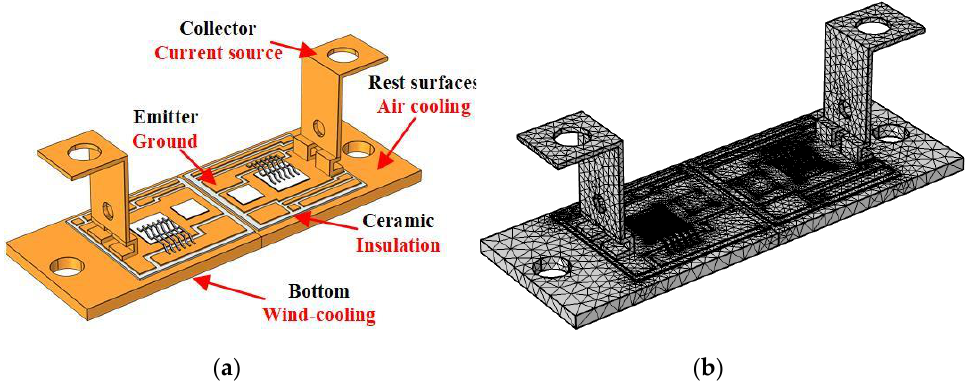
Figure 5. ( a ) FEM model of IGBT module ( b ) Meshed FEM model.